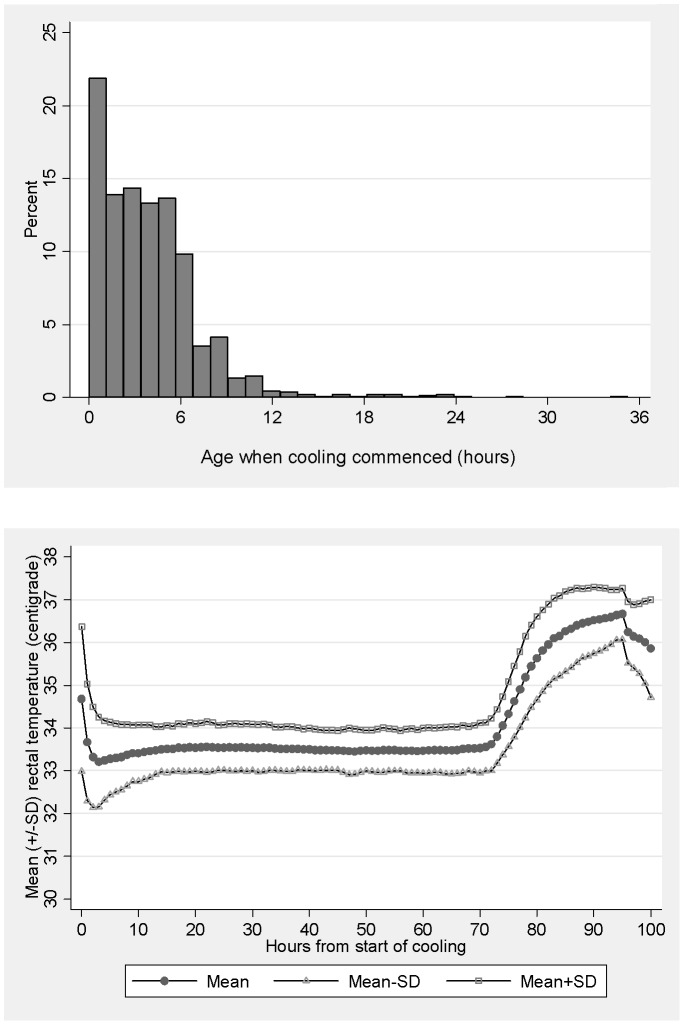
Frequencies of age at start of cooling in hours after birth.